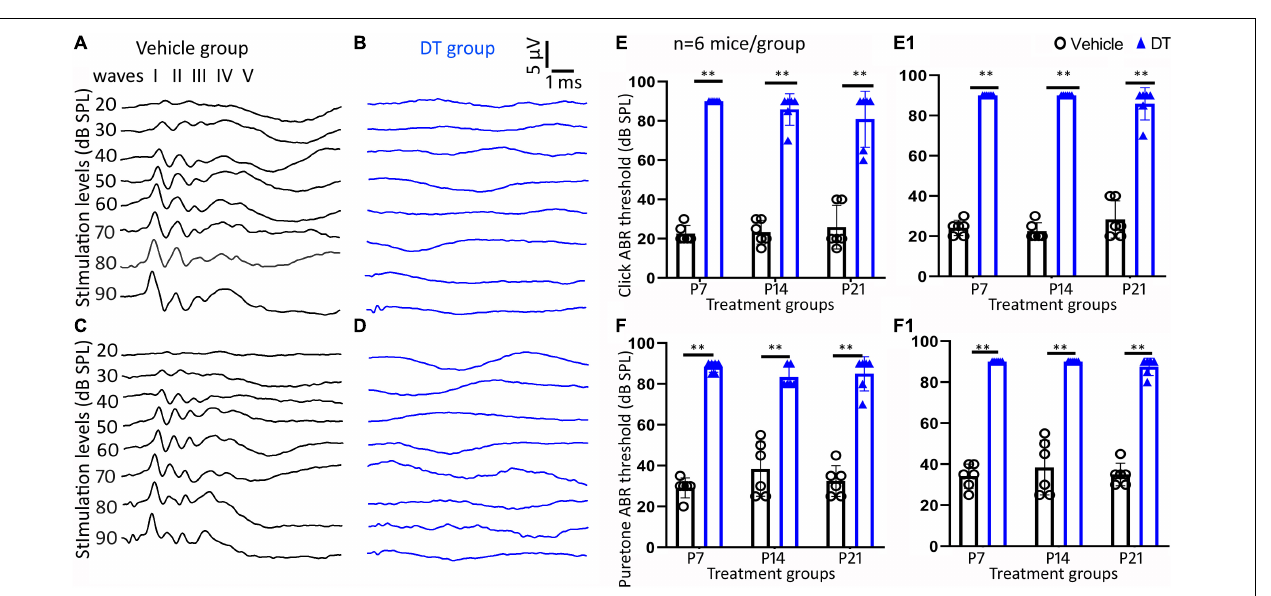
P21; n = 6 mice per group). The overall and the treatment age effects were not statistically significant [ F ( 2 , 30 ) = 3.065, p = 0.0916, and F ( 2 , 30 ) = 1.677, p = 0.2355, respectively]. However, the effect